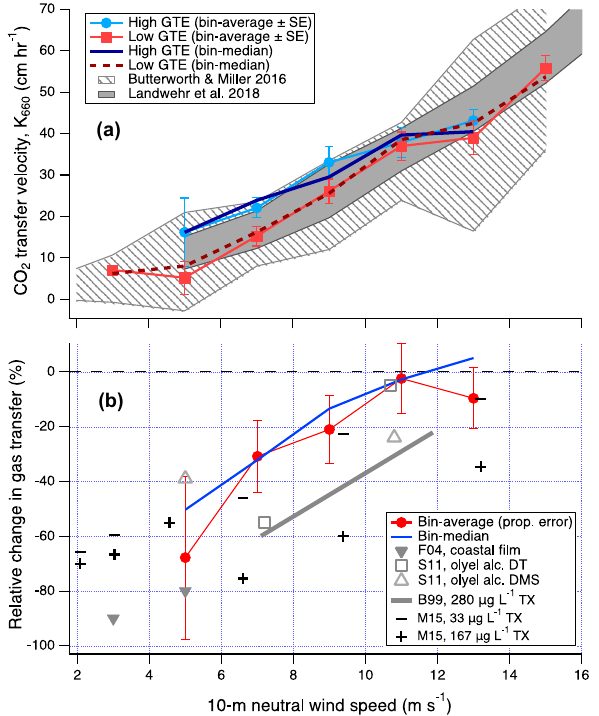
Figure 3. ( a ) K 660 vs. 10-m neutral wind speed, separated according to high and low GTE (mean and medium in wind speed bins). K 660 with high GTE clearly lies above K 660 with low GTE. To illustrate the variability in previous observations, results from ref. 10,11 are shown as bin average ± 1 standard deviation (computed from hourly data). ( b ) Relative change in K 660 explainable by GTE, which was greatest at low wind speeds and diminished towards high wind speeds during this transect. Also shown are previous estimates of gas